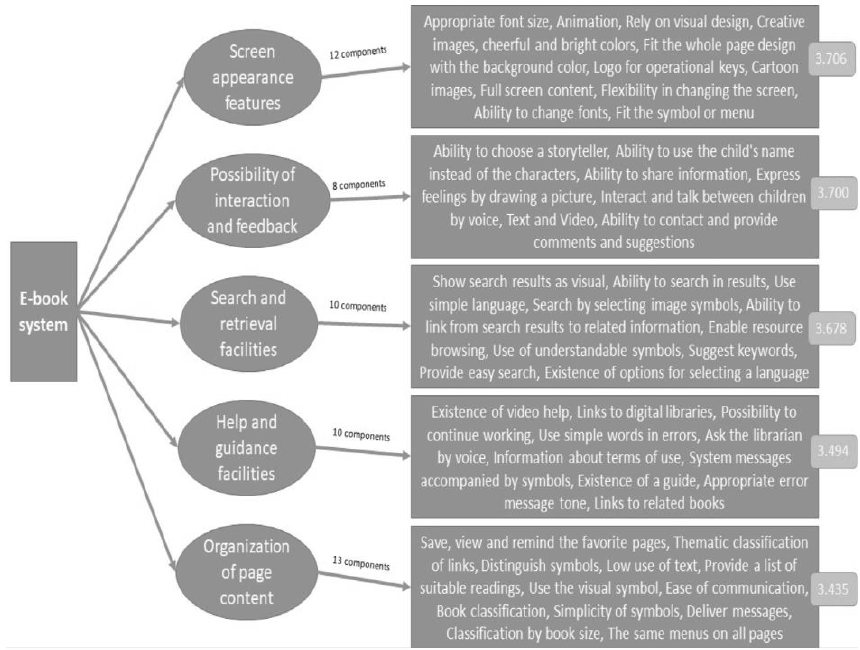
Figure1. Proposed conceptual model of child and adolescent e-book reading